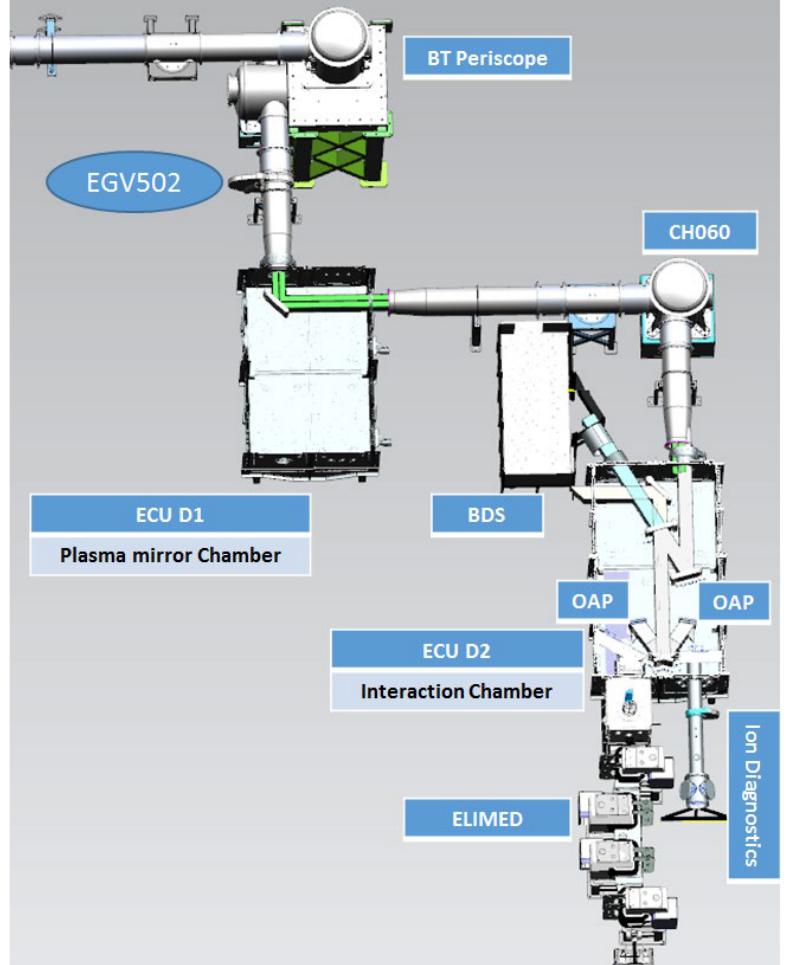
Figure 3. Details of the final L3BT section before the injection of the L3 beam into the ELIMAIA plasma accelerator. The BT Periscope redirects the L3 beam down and injects it into the ECU-D1 Plasma Mirror Chamber. The valve EGV502 (equipped with 100 mm window) allows operation with the following vacuum section in air, or in vacuum, as it is equipped with a glass window. In the current configuration, the ECU-D1 chamber is equipped with a turning mirror (no plasma mirror is used), and the laser beam is sent into the next turning chamber (CH060) and finally into the ECU-D2 Interaction Chamber. The optical setup in the Interaction Chamber can be arranged symmetrically in two configurations using the same optical elements. The ion beams can be either accelerated along the ELIMED or the Ion Diagnostics axes (both setups are visible in the schematic). A leak mirror in ECU-D2 sends the beam to the Beam Diagnostic Station for online, full-power laser characterization. A detailed view of the optical setup is shown in Figure 4 .